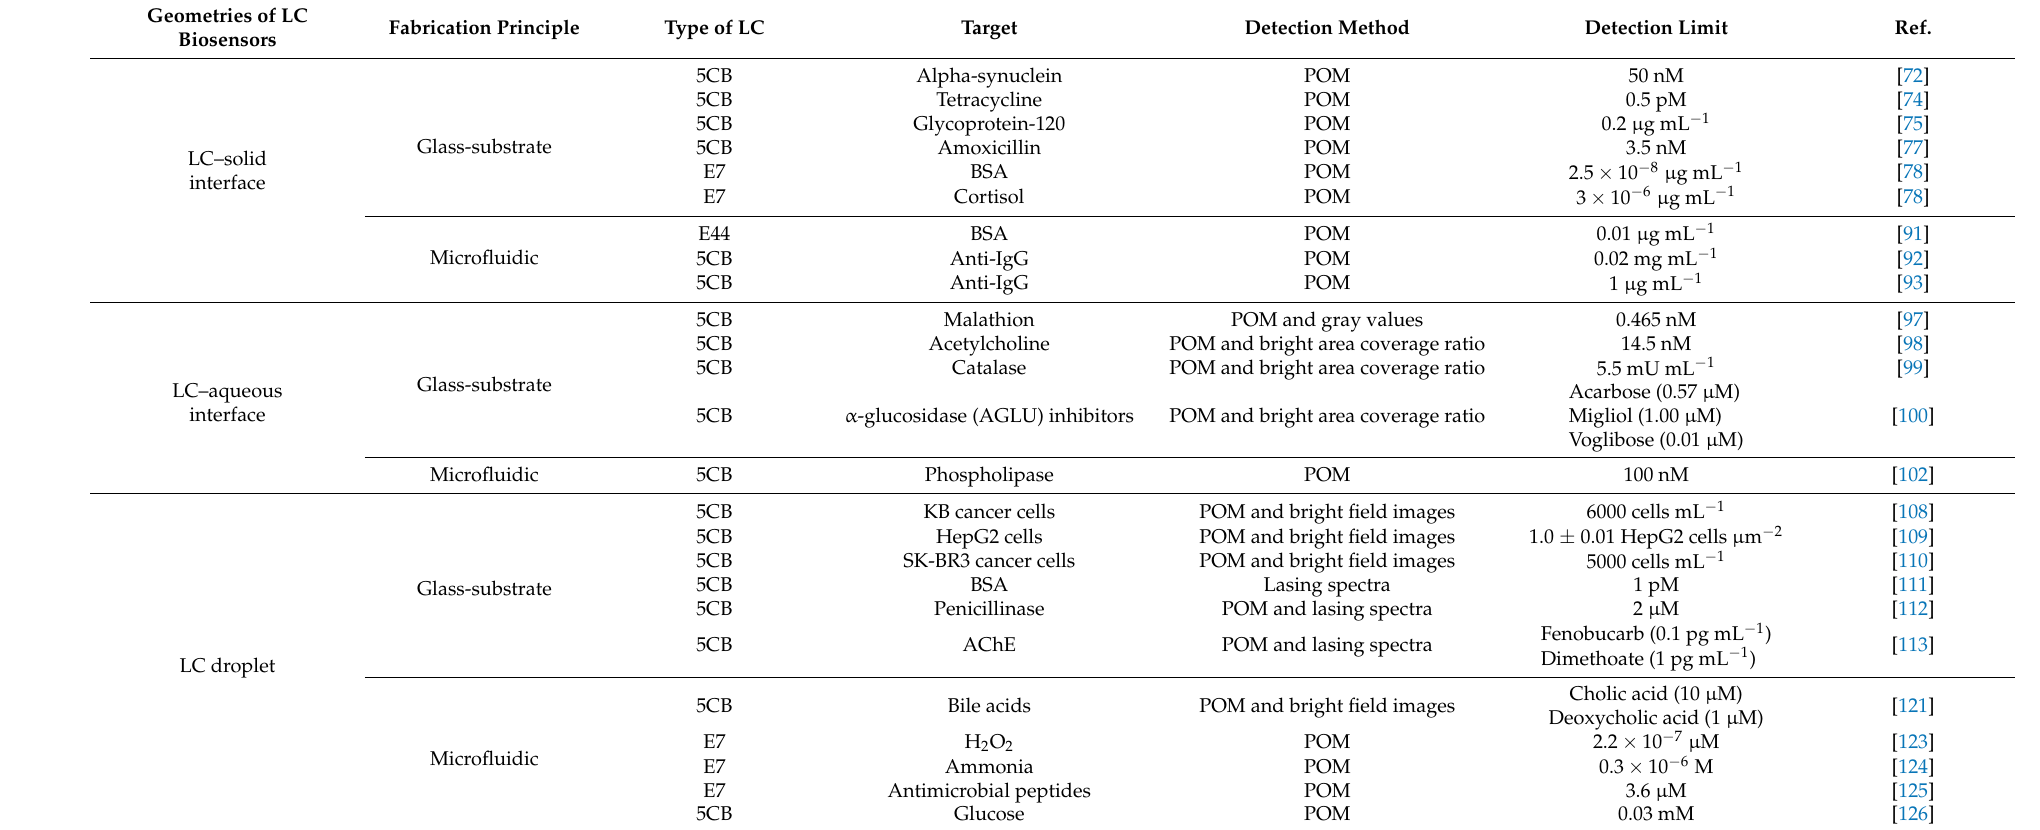
Table 1. Summary of different geometries of LC biosensors used in detecting